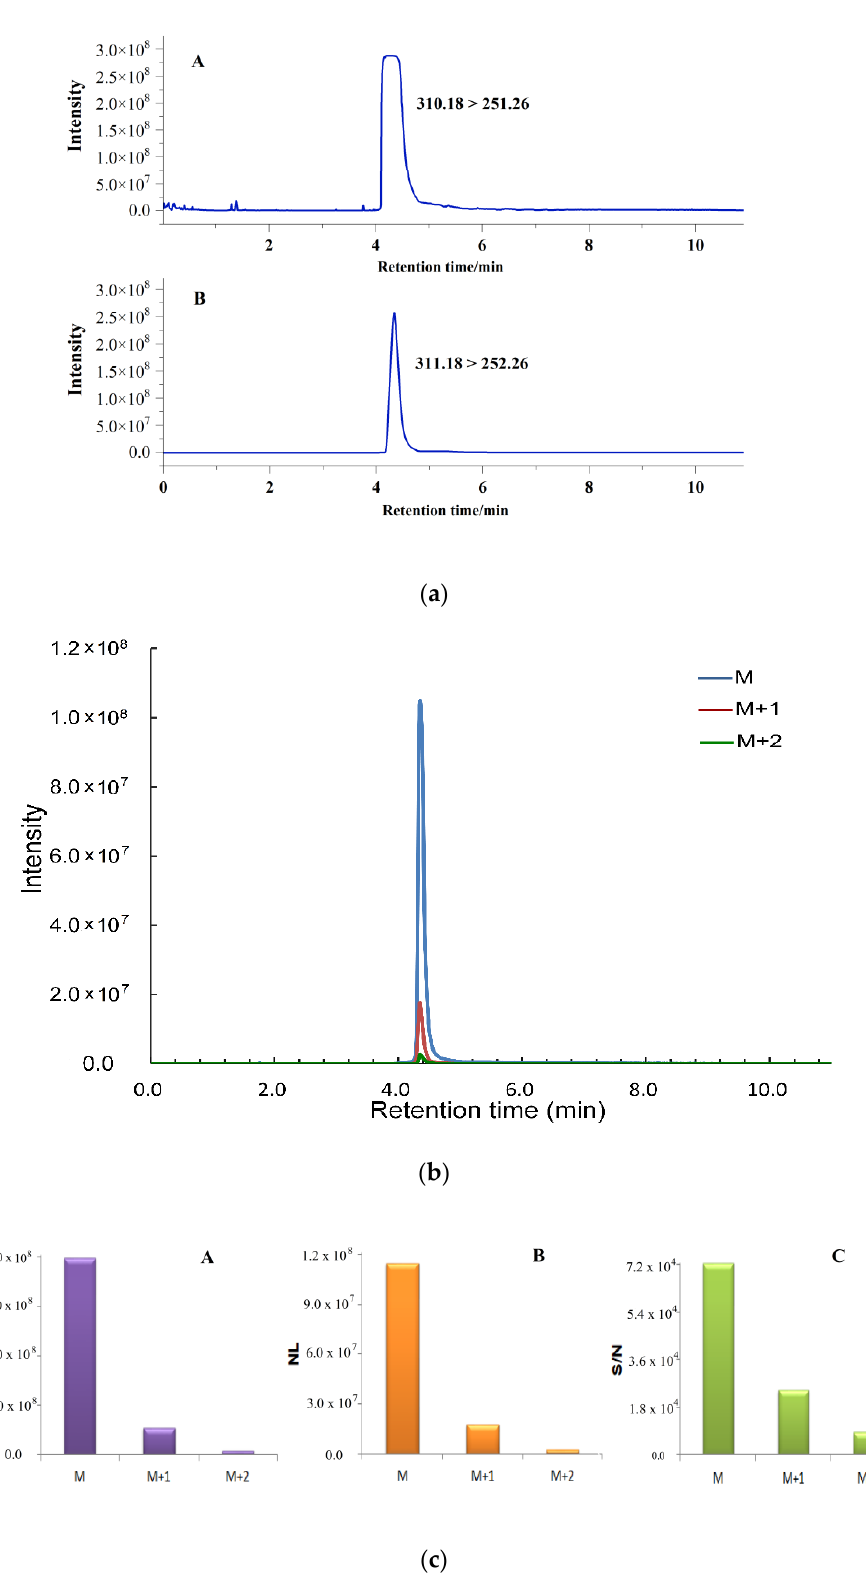
Figure 1. ( a ) Chromatogram of molecular ion (A: [M] + ) and isotope ion (B: [M + 1] + ) of sinapine in rapeseed; ( b ) chromatogram of isotopic ions of sinapine in standard solution; and ( c ) comparison of peak area, response value and signal-to-noise ratio of isotope ion chromatogram of sinapine (5 mg/kg).